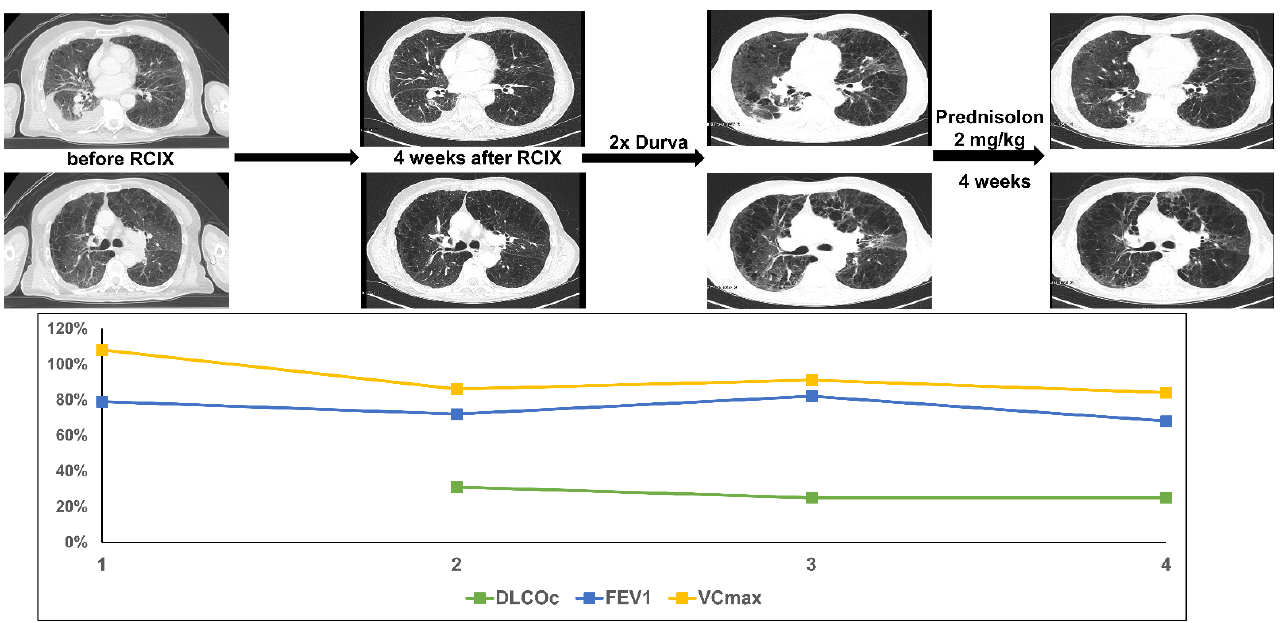
Figure 3. The figure shows course of treatment, corresponding CT imaging and lung function values of patient 3. (RCIX: Radiochemoimmunotherapy; Durva: Durvalumab).